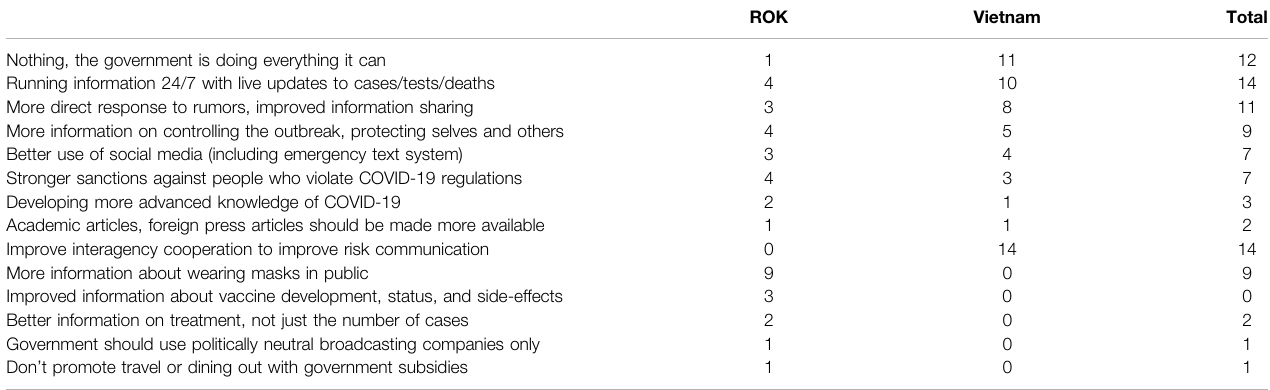
TABLE 8 | Improving the government response to COVID-19, citizen recommendations.